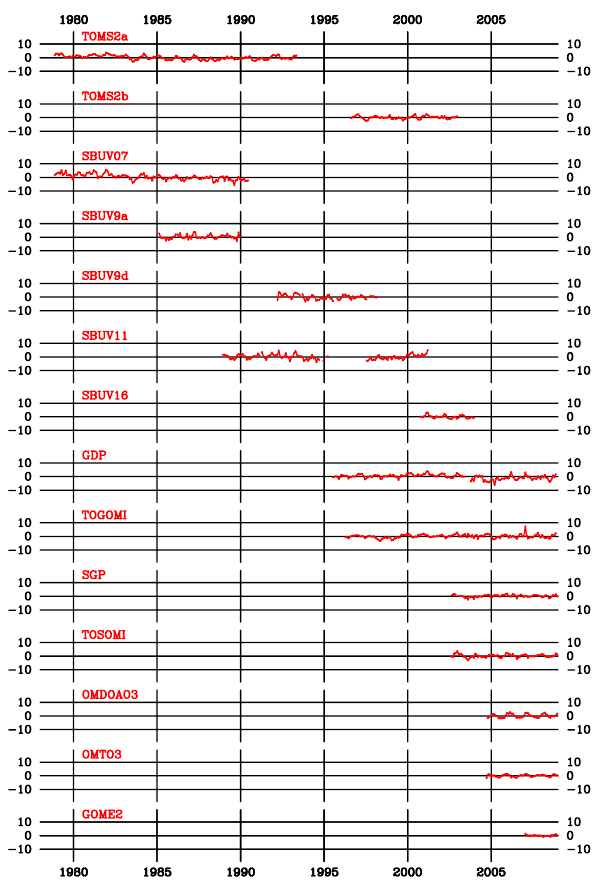
Fig. 2b. Monthly averaged and globally averaged difference of the corrected (as described in Sect. 3.5) satellite ozone observation mi- nus the ground observation in units of DU, for all satellite data sets used as function of